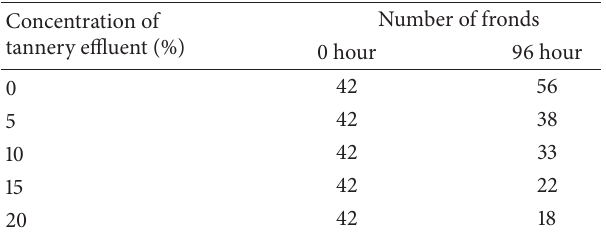
Table 4: Effect of tannery effluent on number of fronds in Lemna minor (all values are mean range for three observations